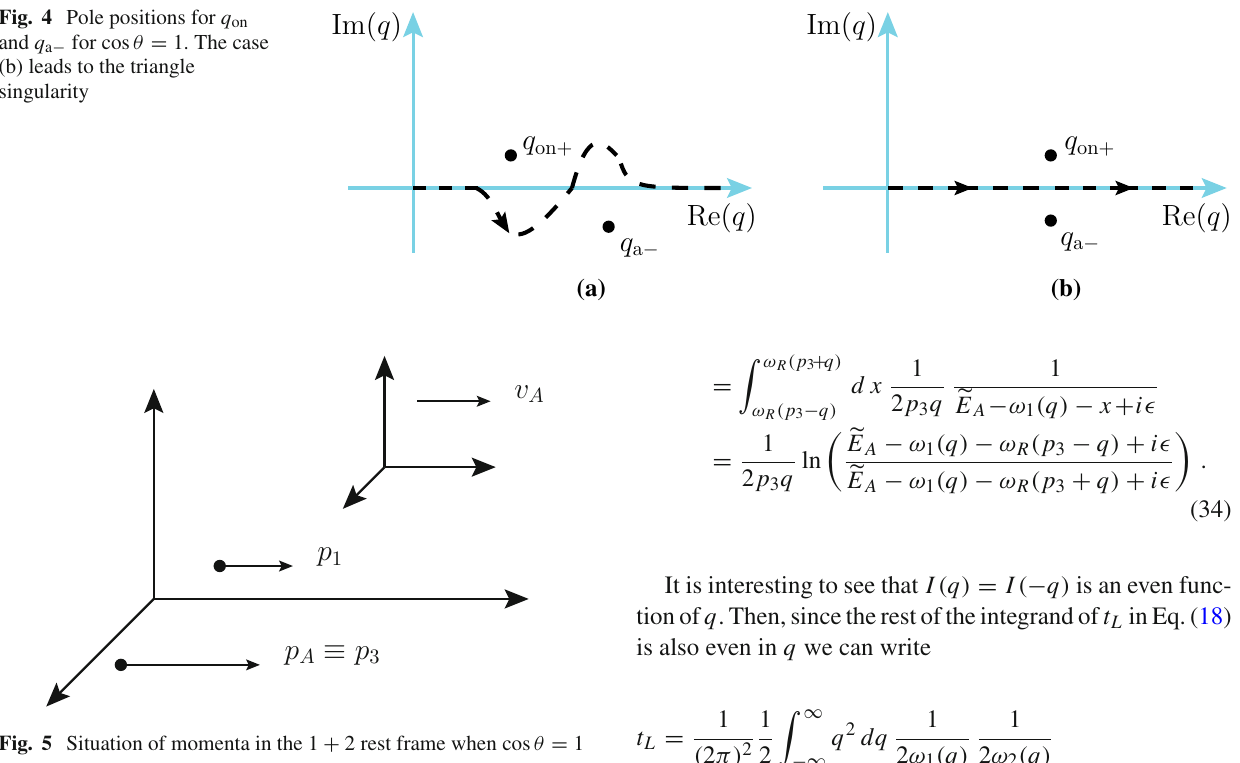
Fig. 5 Situation of momenta in the 1 + 2 rest frame when cos θ = 1